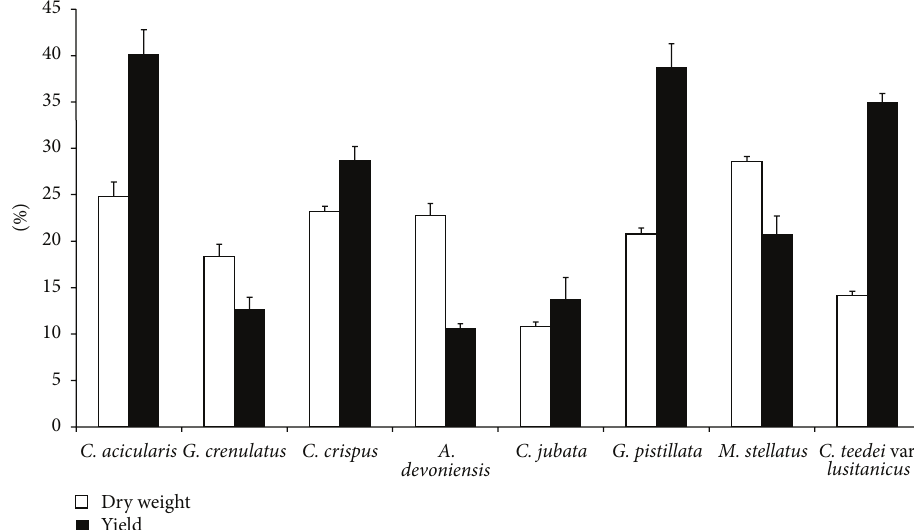
Figure 1: Carrageenophytes dry weight expressed as the percentage of fresh weight and carrageenan yields expressed as the percentage of dry weight (average ± standard error, 𝑛 = 13 ).